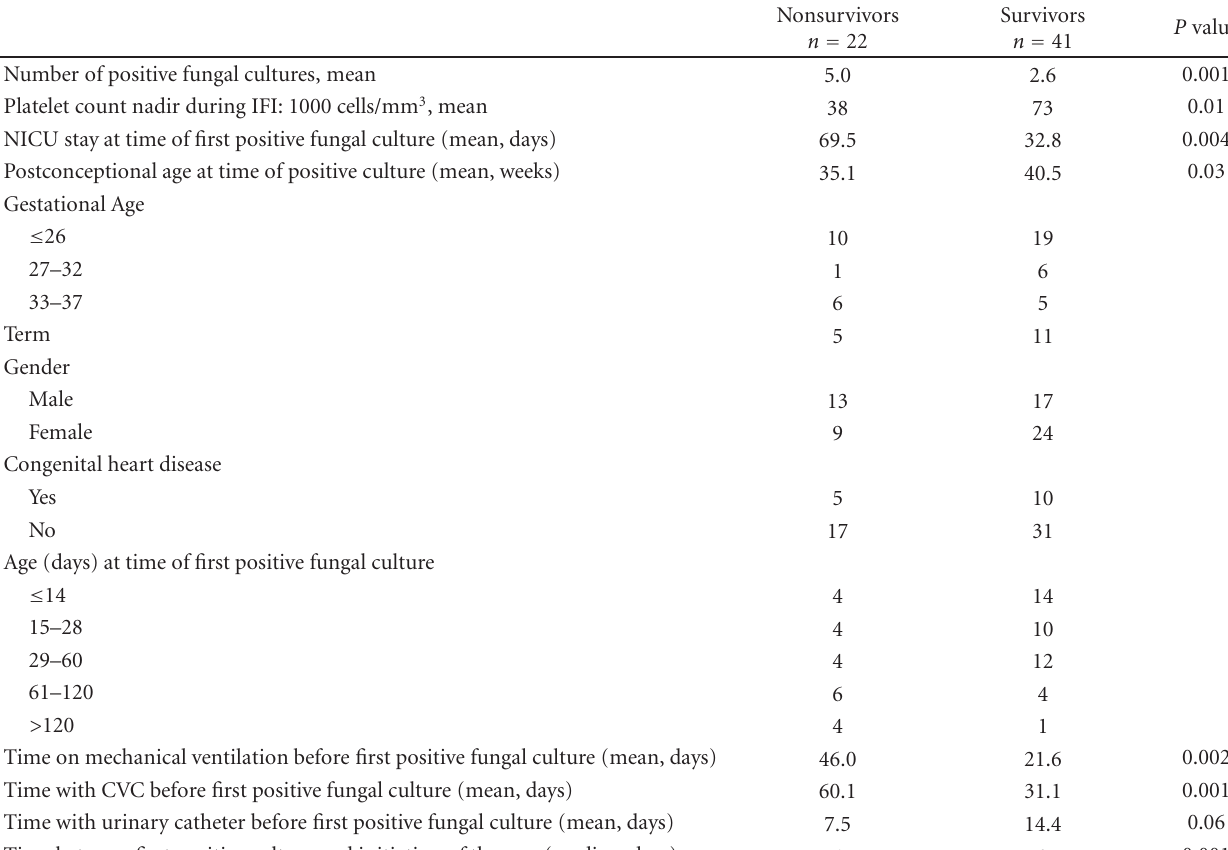
Table 1: Mortality risk factors: comparison between nonsurvivor and survivor groups.